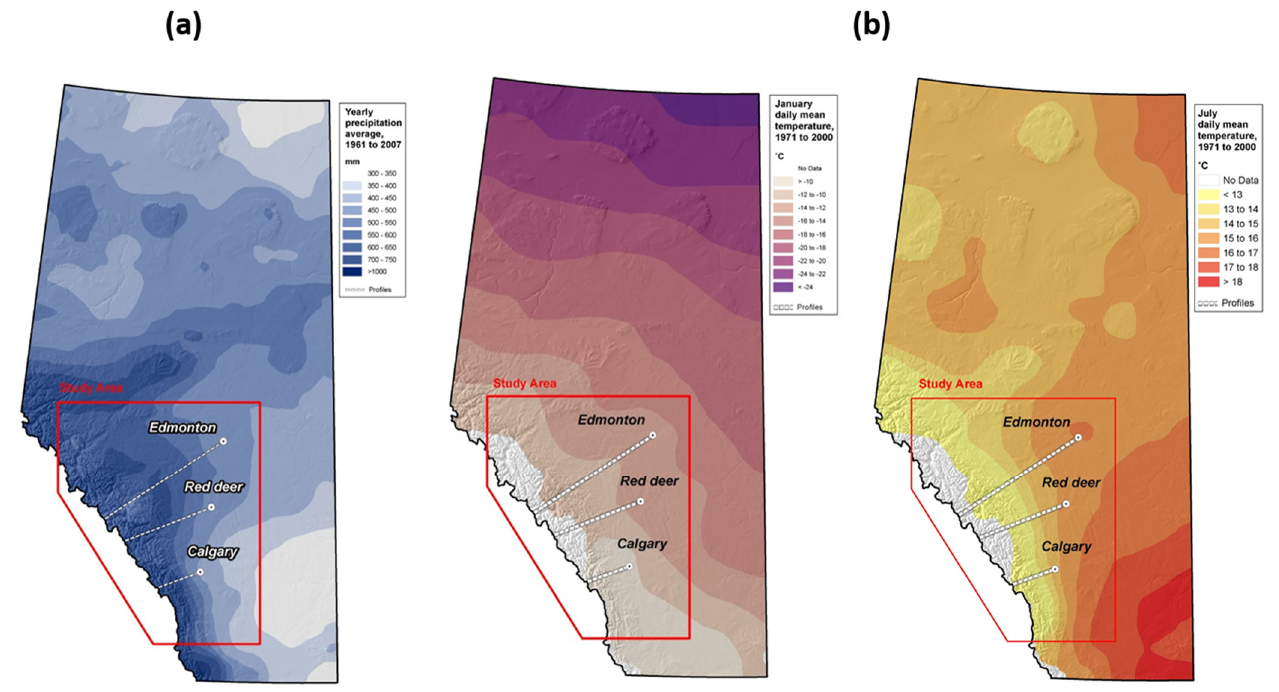
Figure 2. ( a ) mean annual precipitation in the province of Alberta based on data for the 30-year period 1971 to 2000 [18]. ( b ) Mean of daily temperatures for January and July [19]. The study area is indicated in red and cross sections are indicated by dotted lines.